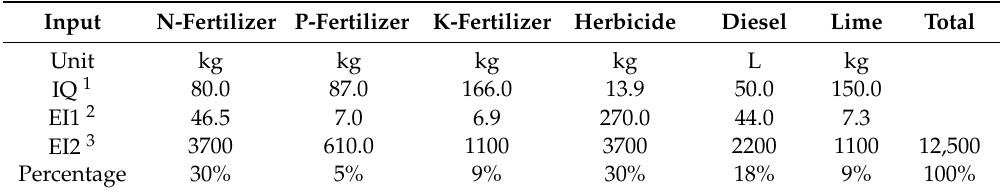
Table 3. Energy consumption in the switchgrass planting unit.